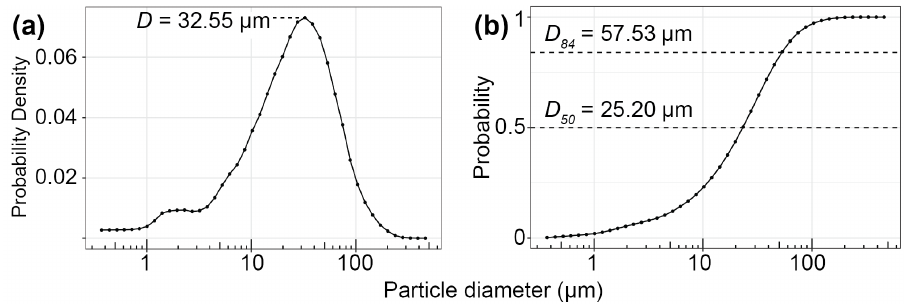
Figure A1. Walnut shell flour (WF5-200) particle size distribution, as measured by LISST-XR|Portable. ( a ) Probability density function, with mode (32.55µm) indicated. ( b ) Cumulative density function, with 50th (25.20µm) and 84th (57.53µm) percentiles